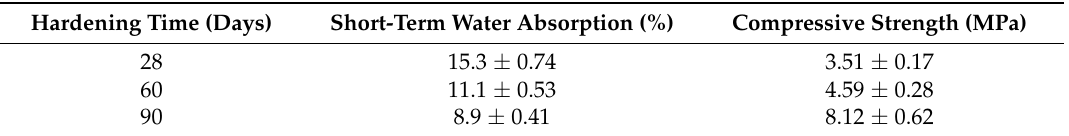
Table 4. Development of compressive strength and short-term water absorption of bio-composite with binder composition of B7 in relation to hardening